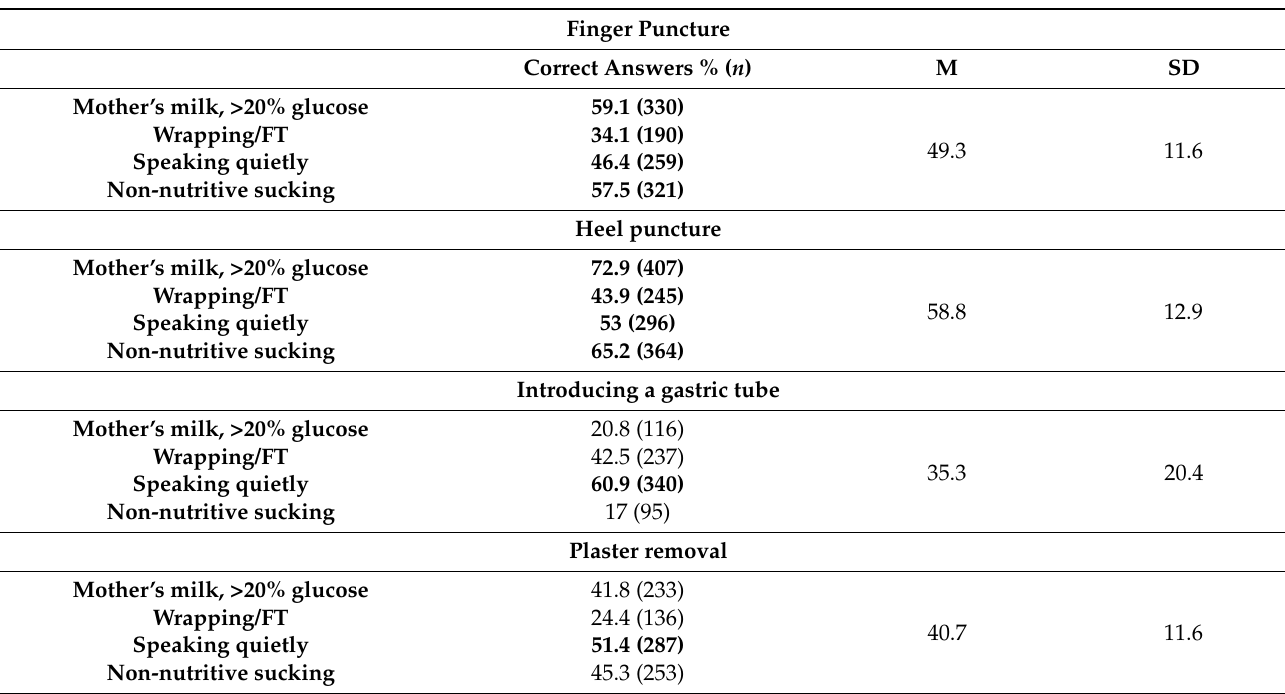
Table 4. The distribution of answers given by the respondents with respect to pharmacological and non-pharmacological methods applied in the selected medical